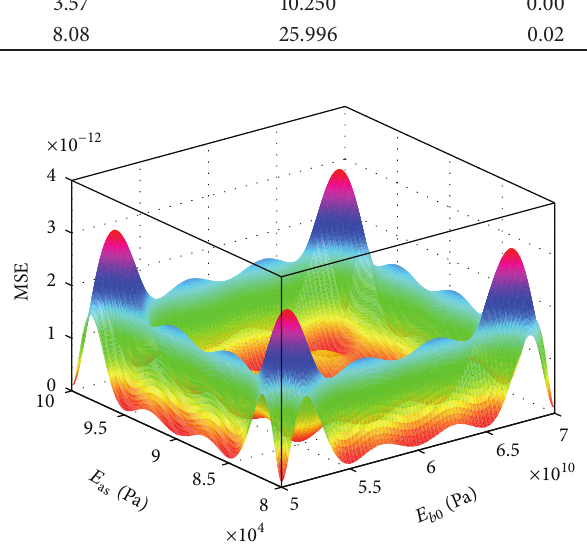
Figure 11: Mean squared errors of the first natural frequency.